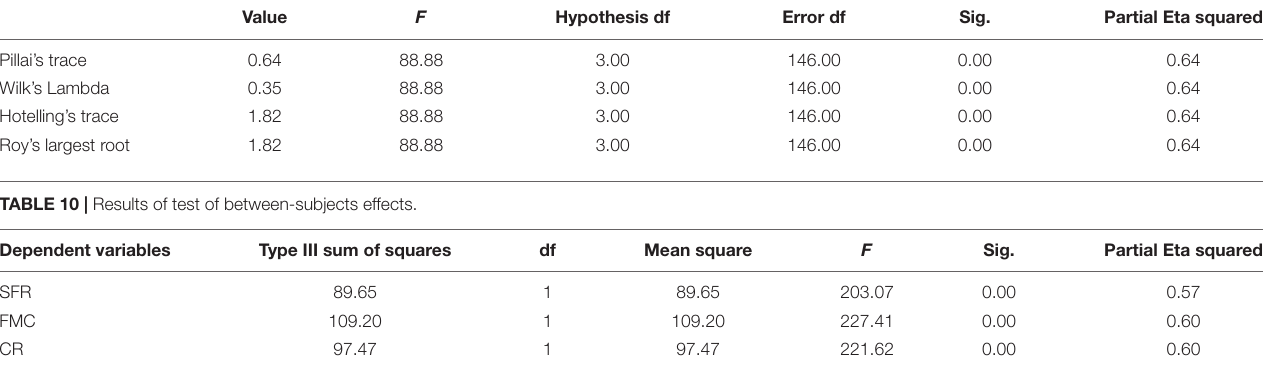
TABLE 9 | MANOVA results comparing experimental group (EG) and control group (CG) on spoken-form recognition (SFR), form-meaning connection (FMC), and collocation recognition (CR) scores on the delayed post-test. Value F